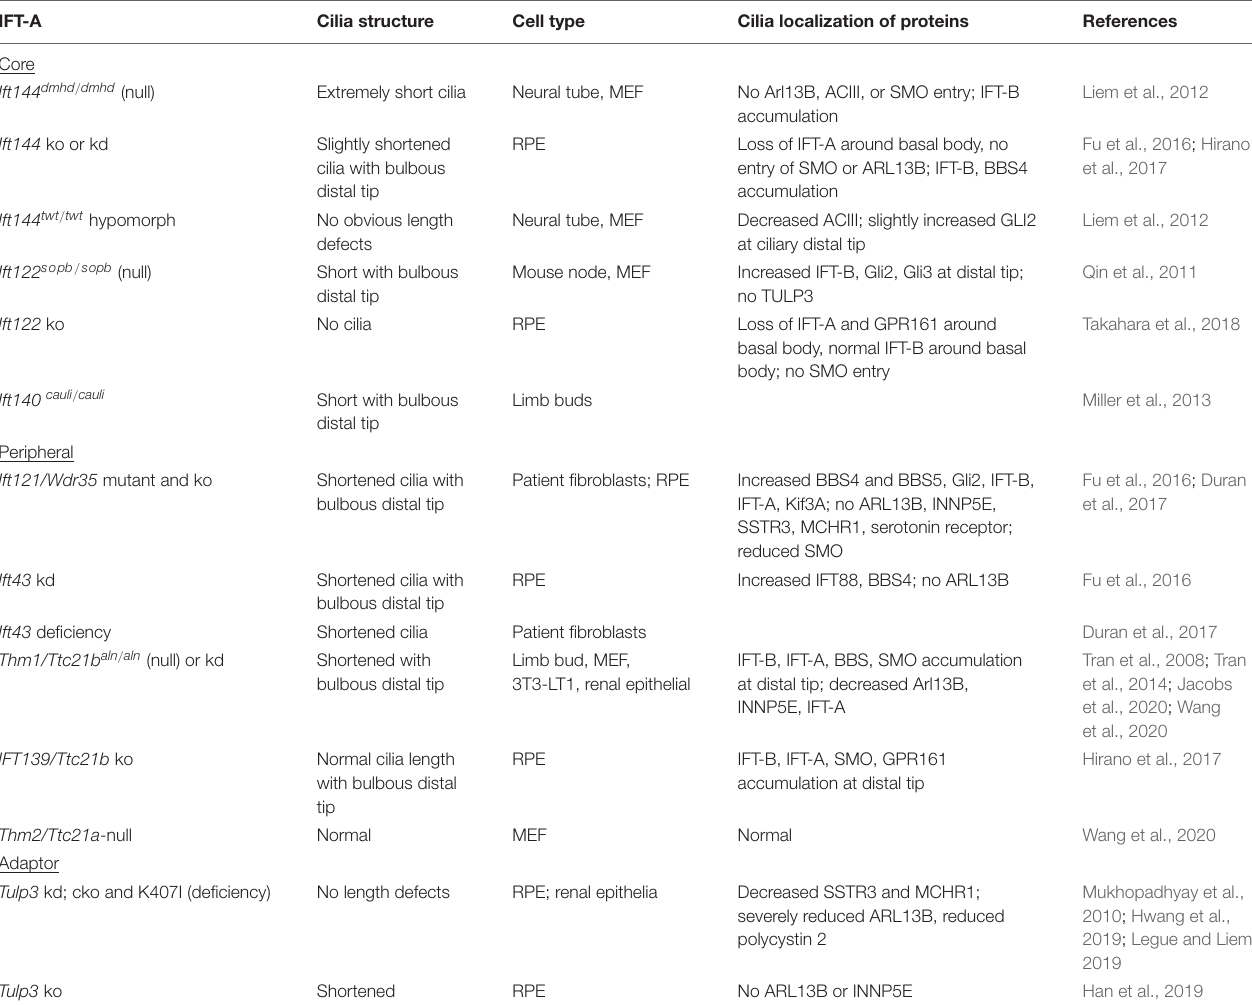
TABLE 3 | Mammalian IFT-A ciliary